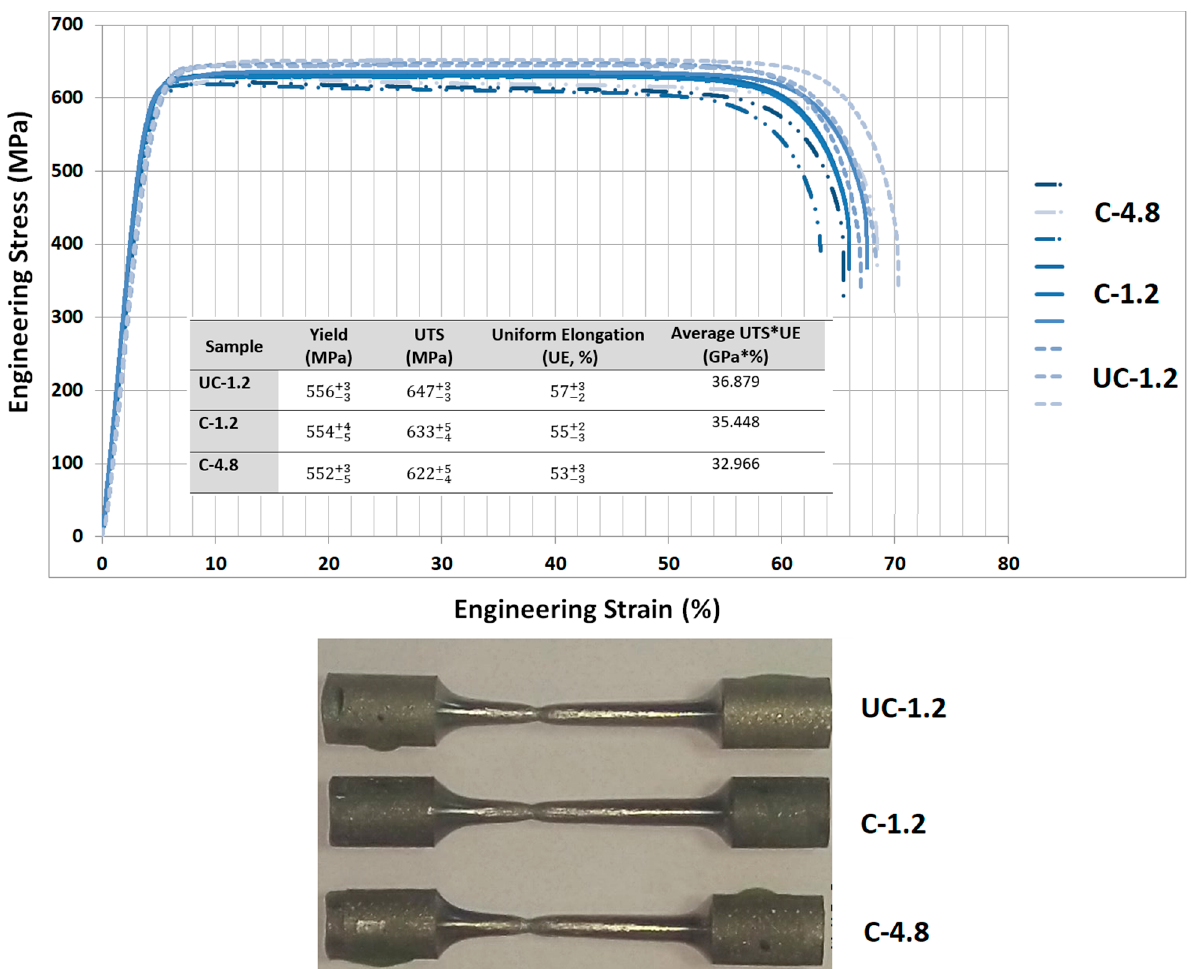
Figure 3. Engineering stress–strain curves of different samples, i.e., UC-1.2, C-1.2, and C-4.8. The tensile properties and images of fractured surfaces after tensile tests are superimposed below the tensile curves.